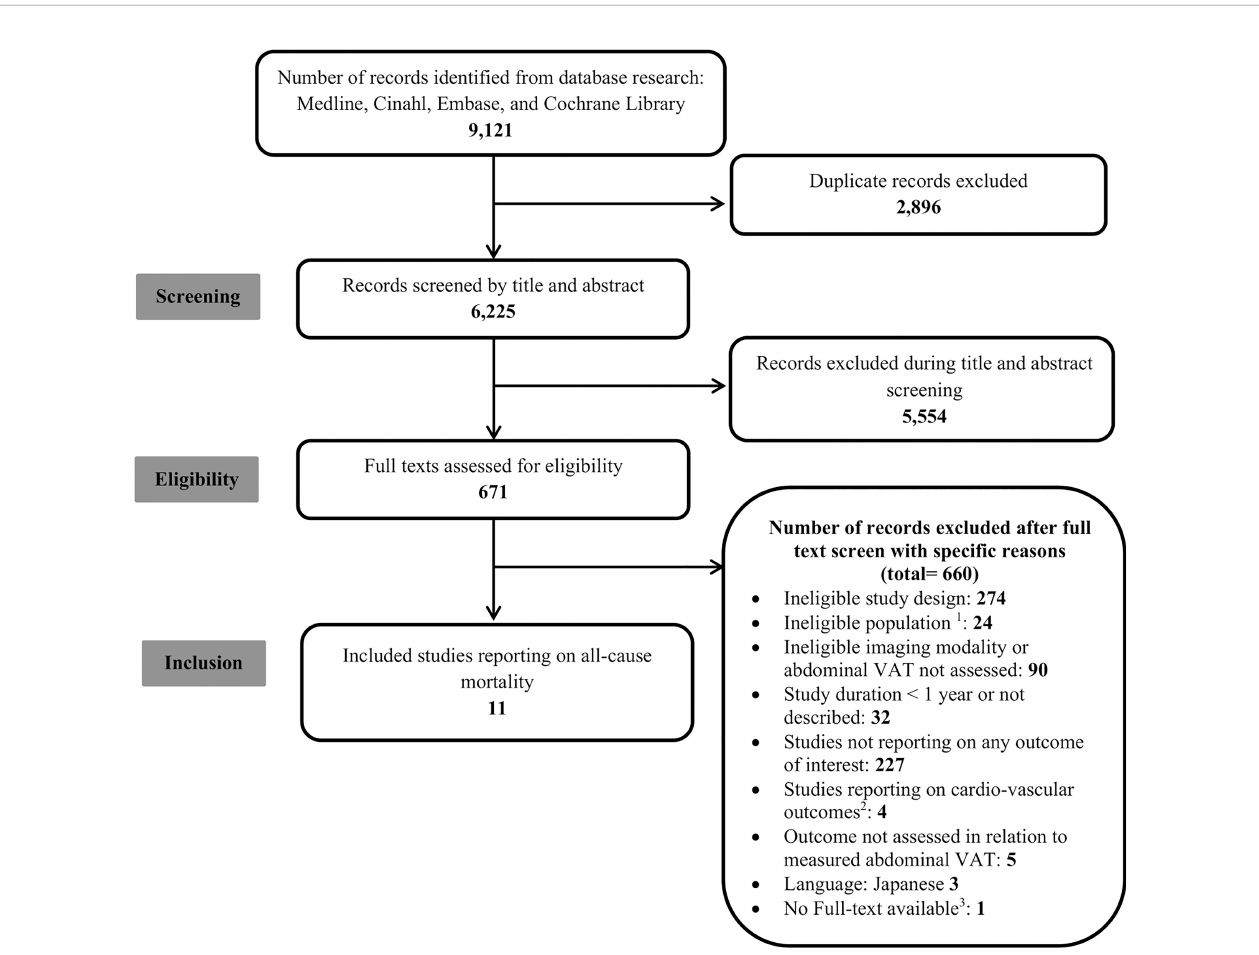
FIGURE 1 | Flow Diagram. 1 Age < 18; pregnant women; baseline cardiovascular, cerebrovascular, chronic kidney or cirrhotic liver disease; malignancy; transplant; Human Immunode fi ciency Virus infection; abdominal surgery; conditions associated with abnormal fat distribution (lipodystrophy, malnutrition, parental nutrition, endocrinopathies, autoimmune conditions, drug-injection, trauma or stress, and chromosomal abnormalities); 2 Cardio-vascular outcomes are eligibile as per our registered protocol but are beyond the scope of the current manuscript; 3 We were not able to fi nd the full text even after seeking help from a medical